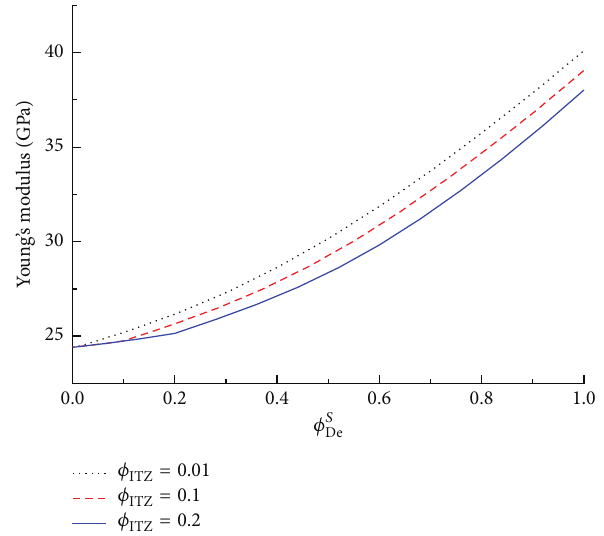
Figure 12: Influence of the ITZ on the Young modulus of repaired concrete during the healing process, where 𝜙 ITZ is the volume fraction of ITZ in the equivalent particle; 𝜙 𝑆 De is the volume fraction of the deposition products in the equivalent